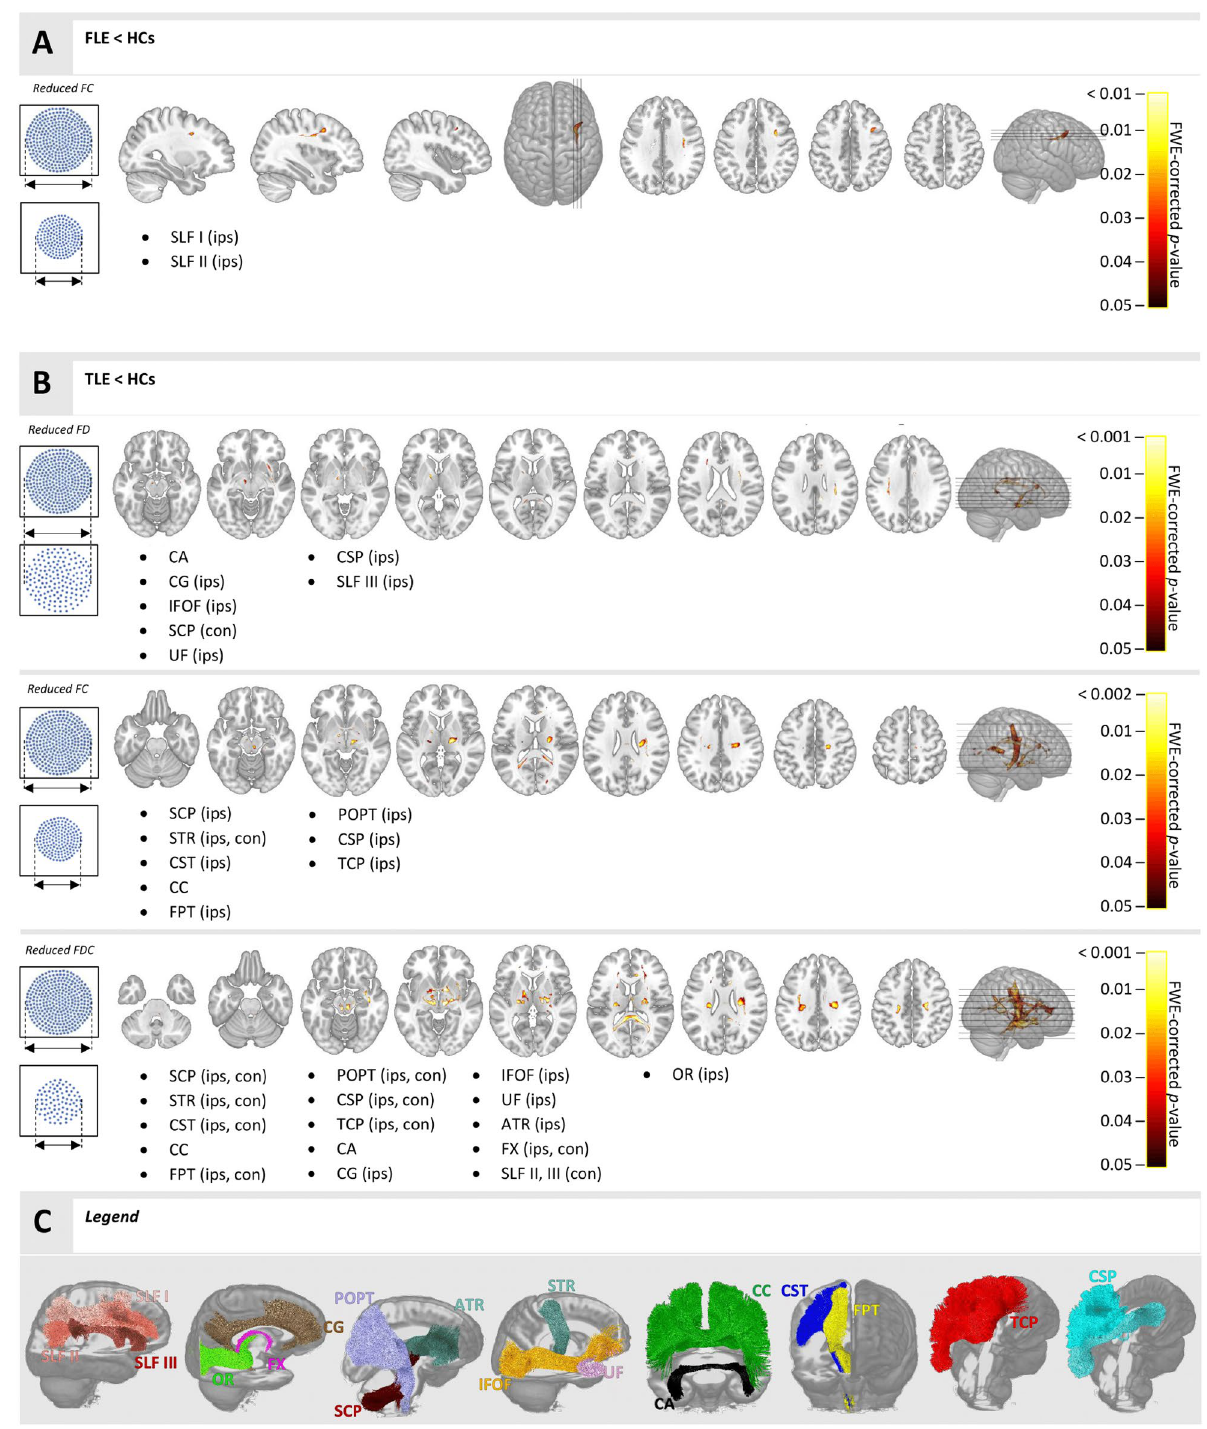
Figure 1. ( A , B ) Group analysis results—overlay of fixels with statistically significant effects (p < 0.05, FWE corrected) on the anatomical template (with listings of WM bundles corresponding to these fixels). ( A ) FLE vs HC statistical comparison in FC; ( B ) TLE vs HC statistical comparison in FD, FC, and FDC; ( C ) Complete 3D visualization of WM bundles with any previous significant results. FLE, frontal lobe epilepsy subjects; HC, healthy control subjects; TLE, temporal lobe epilepsy subjects; FD, fibre density; FC, fibre cross-section; FDC, fibre density and cross section; SLF, superior longitudinal fasciculus; CG, cingulum; OR, optic radiation; FX, fornix; STR, superior thalamic radiation; IFOF, inferior fronto-occipital fasciculus; UF, uncinate fasciculus; CST, corticospinal tract; FPT, fronto-pontine tract; POPT, parieto-occipito-pontine tract; ATR, anterior thalamic radiation; SCP, superior cerebellar peduncle; CA, anterior commissure; CC, corpus callosum (anterior midbody, posterior midbody, splenium and isthmus); TCP, thalamocortical projection; CSP, corticostriatal projection; ips, ipsilaterally to resection; con, contralaterally to resection Figure has been generated using mrview (MRtrix3 3.0.3 17 , https:// www. mrtrix. org/) and tracts for Figure Legend were segmented using TractSeg 30 (https:// github. com/ MIC- DKFZ/ Tract